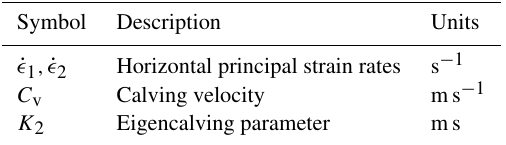
Table A6. Calving variables and parameters.